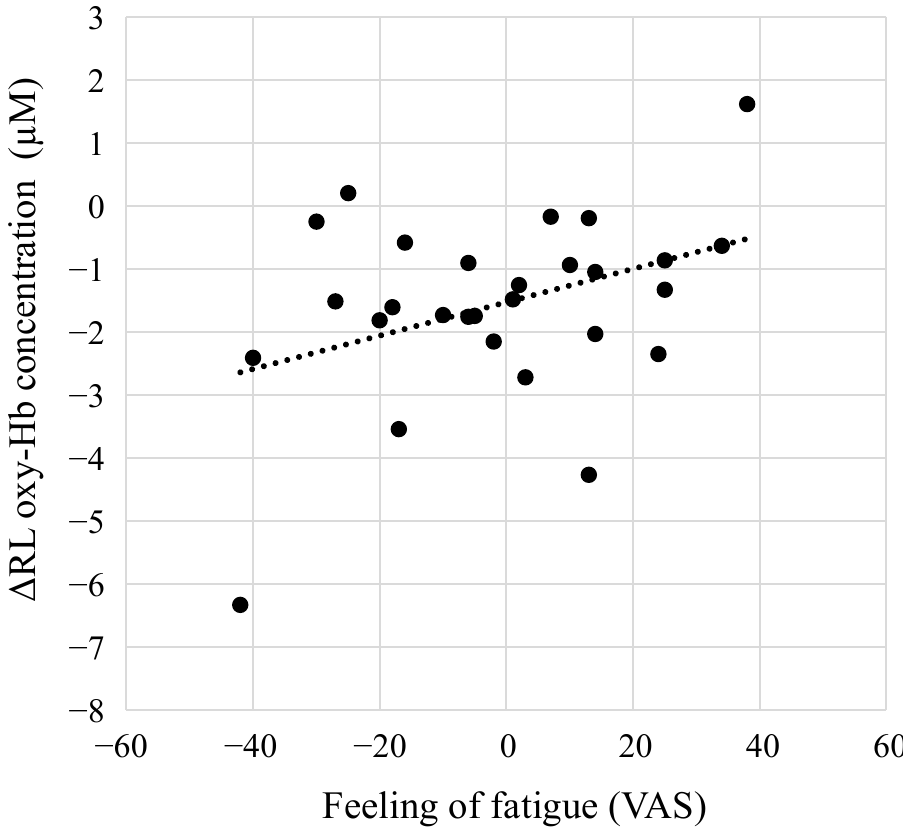
Figure 6. Correlation analysis of feeling of fatigue and time-resolved near-infrared time-resolved spectroscopy data after staying in the experimental spaces. ∆ RL oxy-Hb, right-left difference in oxygenated hemoglobin.